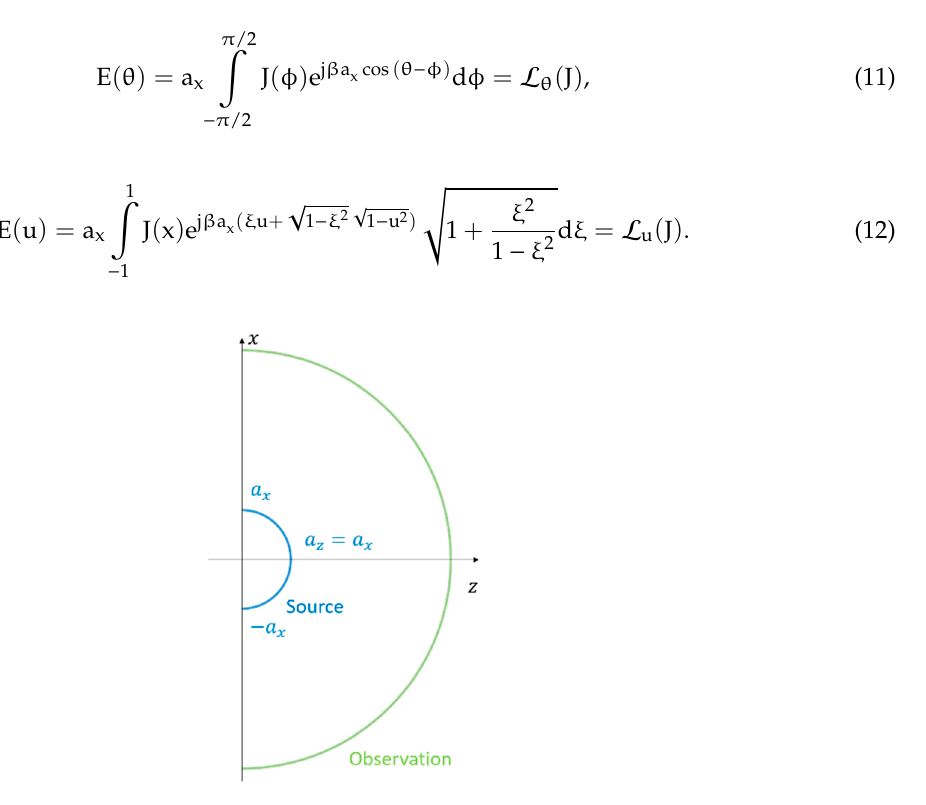
Figure 4. Semi-circumference source geometry.